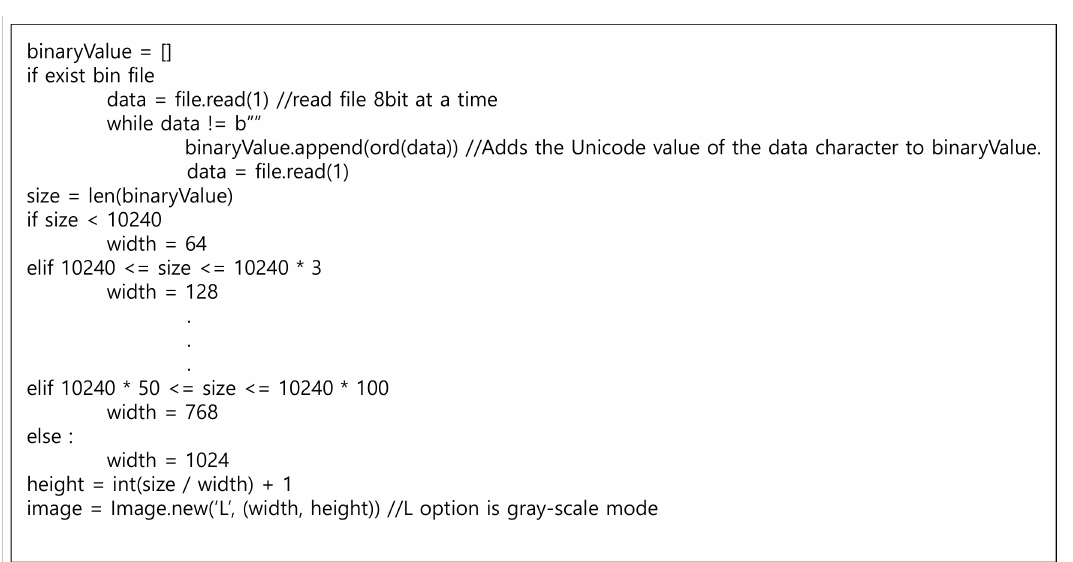
Figure 6. The process of converting .bin file to image.